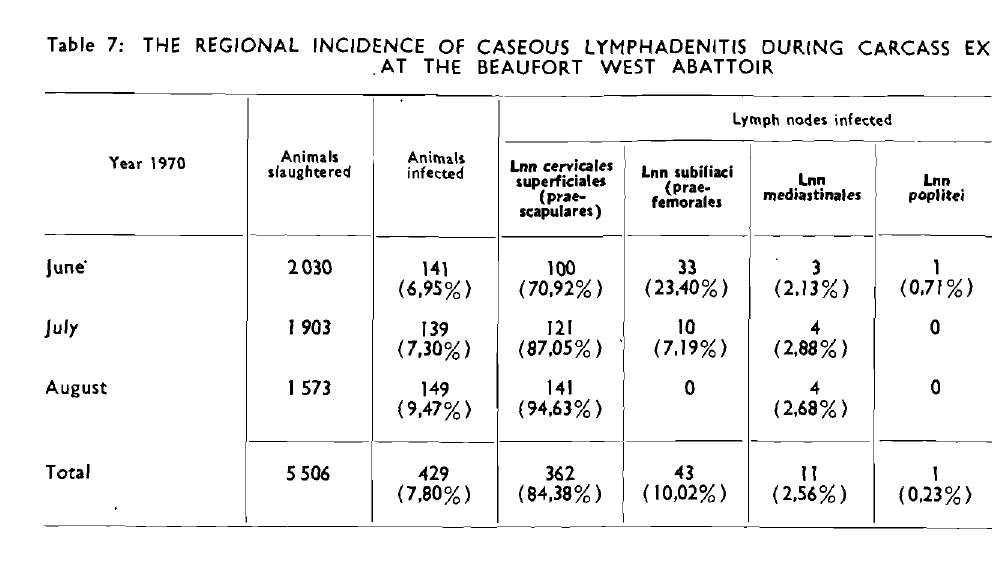
Table 7: THE REGIONAL INCIDENCE OF CASEOUS LYMPHADENITIS DURING CARCASS EXAMINATIONS _AT THE BEAUFORT WEST